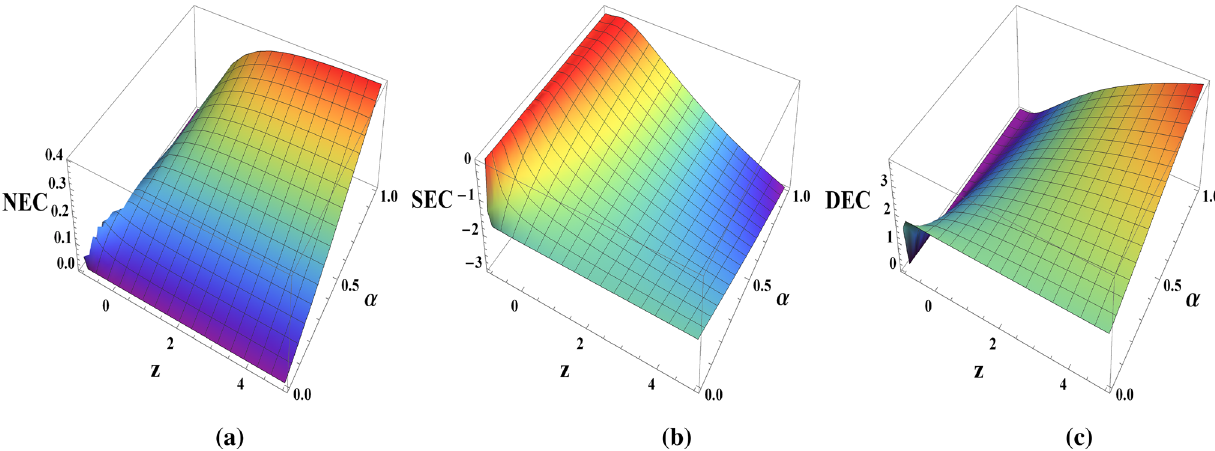
Fig. 9 The plots of energy conditions NEC, SEC and DEC for the